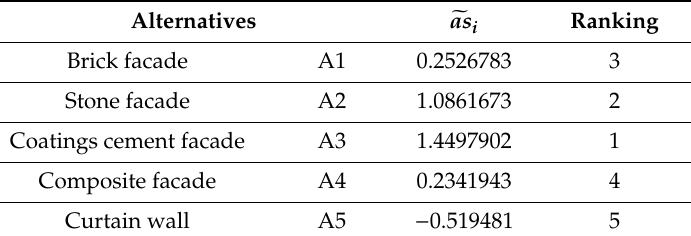
Table 11. Alternatives’ scores and